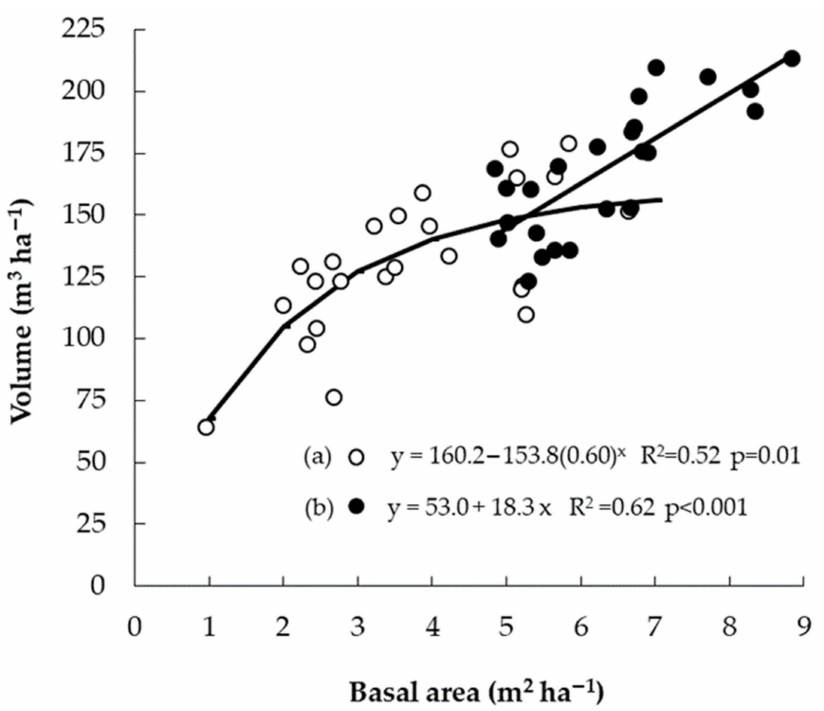
Figure 9. Eucalyptus pellita : relationship between basal area at age 2 years and volume at age 6 years; ( a ) without P (open circle), ( b ) with 12 kg P ha − 1 (closed circle). Data points represent individual plots from all replications and respective treatments from six